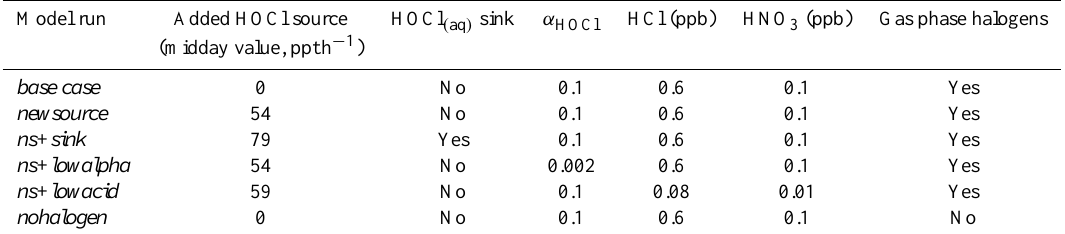
Table 3. Boundary conditions which were varied for the different MECCA box model runs. HNO 3 and HCl for all cases except new- source+lowacid were based on measurements at Cape Verde in 2007. Here ns is short for newsource